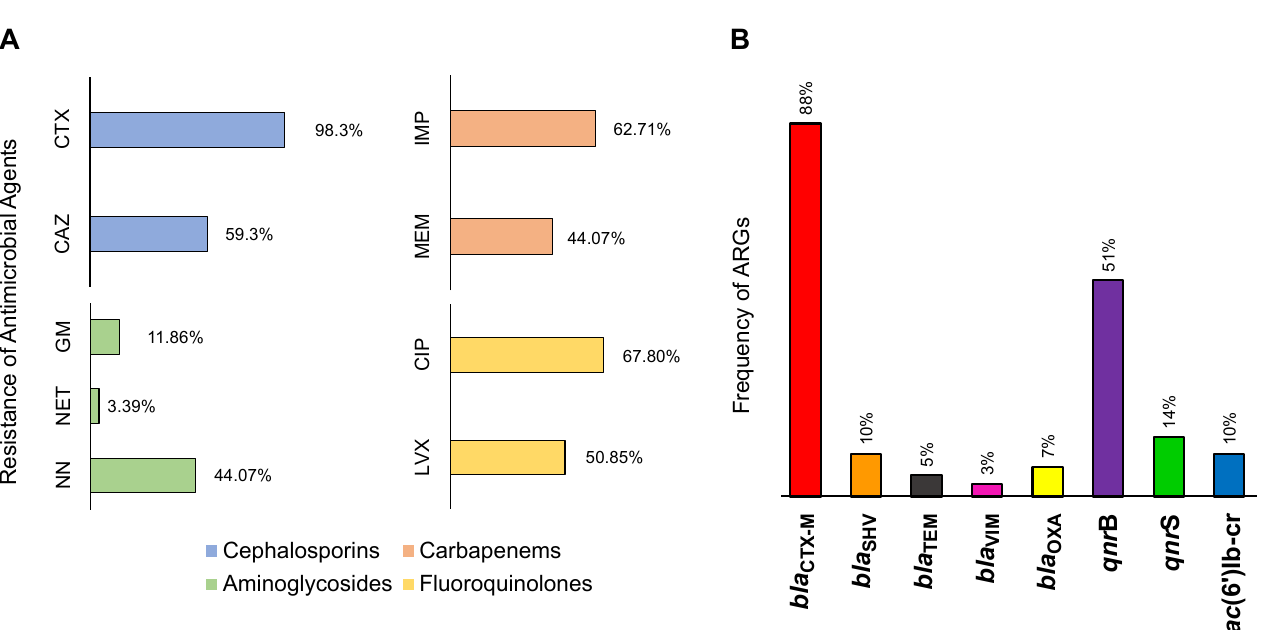
Figure 3. Frequency of resistance to antimicrobial agents and of ARGs that were detected in the Lerma River basin. ( A ) Antimicrobial agents. CAZ: ceftazidime, CTX: cefotaxime, IMP: imipenem, MEM: meropenem, NET: netilmicin, NN: tobramycin, GM: gentamicin, LVX: levofloxacin, and CIP: ciprofloxacin. ( B ) Frequency of ARGs that were studied and detected in the studied strains.